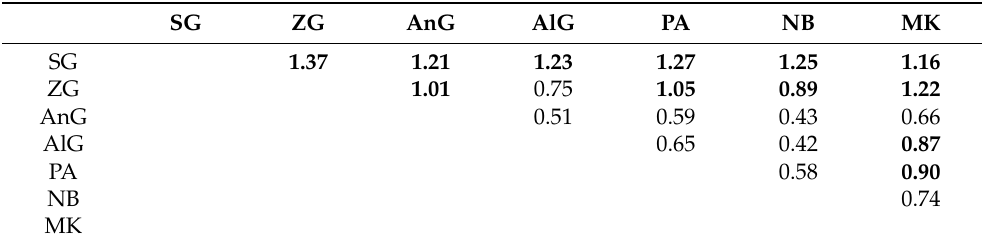
Table 2. Tree species’ inter-specific spectral separability as calculated by the Jeffries–Matusita distance (Equation (1)). The bold shows those species which are separable and those not separable (not in bold).